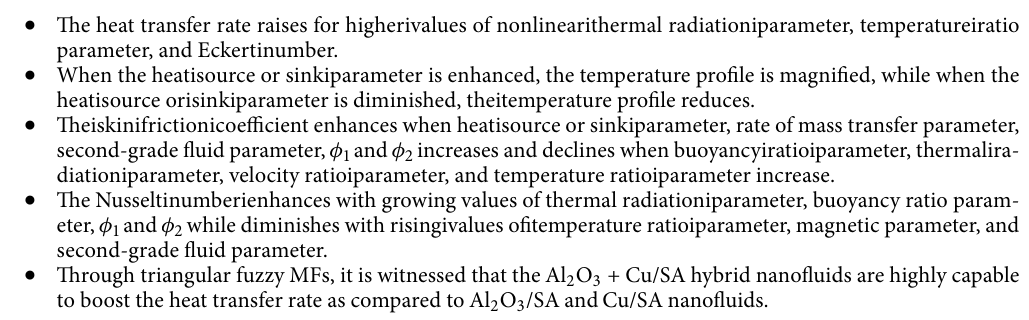
Figure 14. Comparison of Al 2 O 3 /SA, Cu/SA and Al 2 O 3 + Cu/SA hybrid nanofluid for varying of η